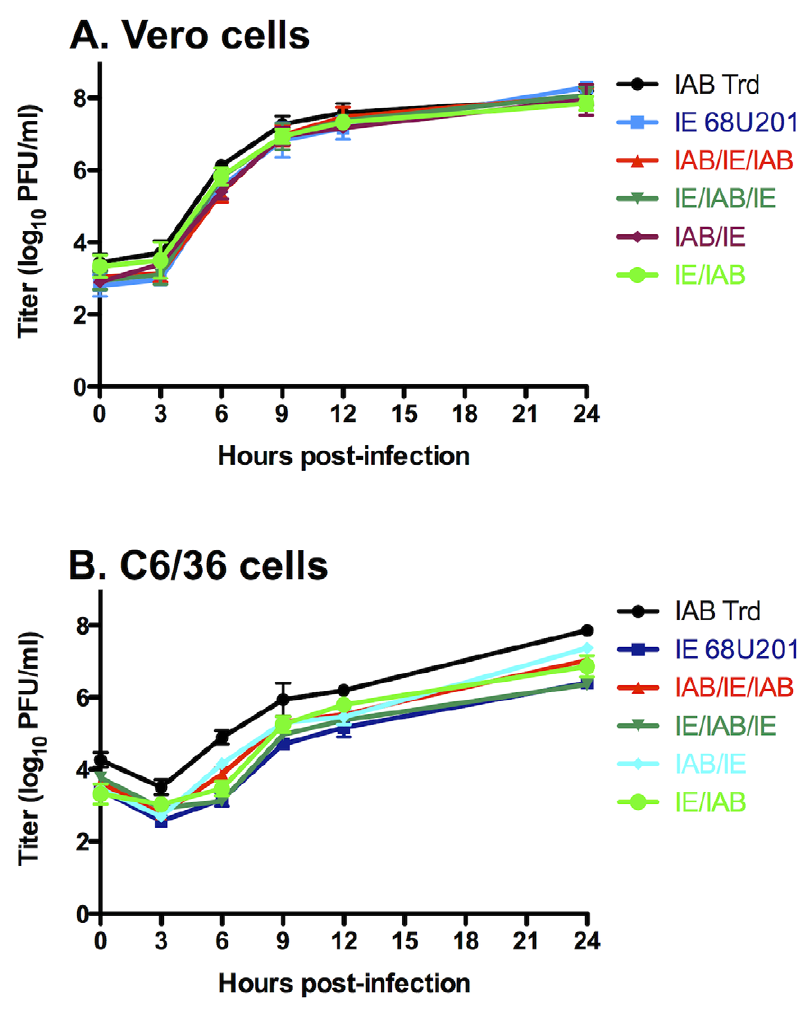
Figure 3. Viral replication kinetics. Comparison of two parental viruses IAB TrD and IE 68U201 and four chimeric viruses, IAB/IE/IAB, IE/IAB/IE, IAB/ IE, and IE/IAB, at a multiplicity of infection (MOI) of 5 on Vero (A) and C6/36 (B) cells. Error bars represent the standard deviation of the